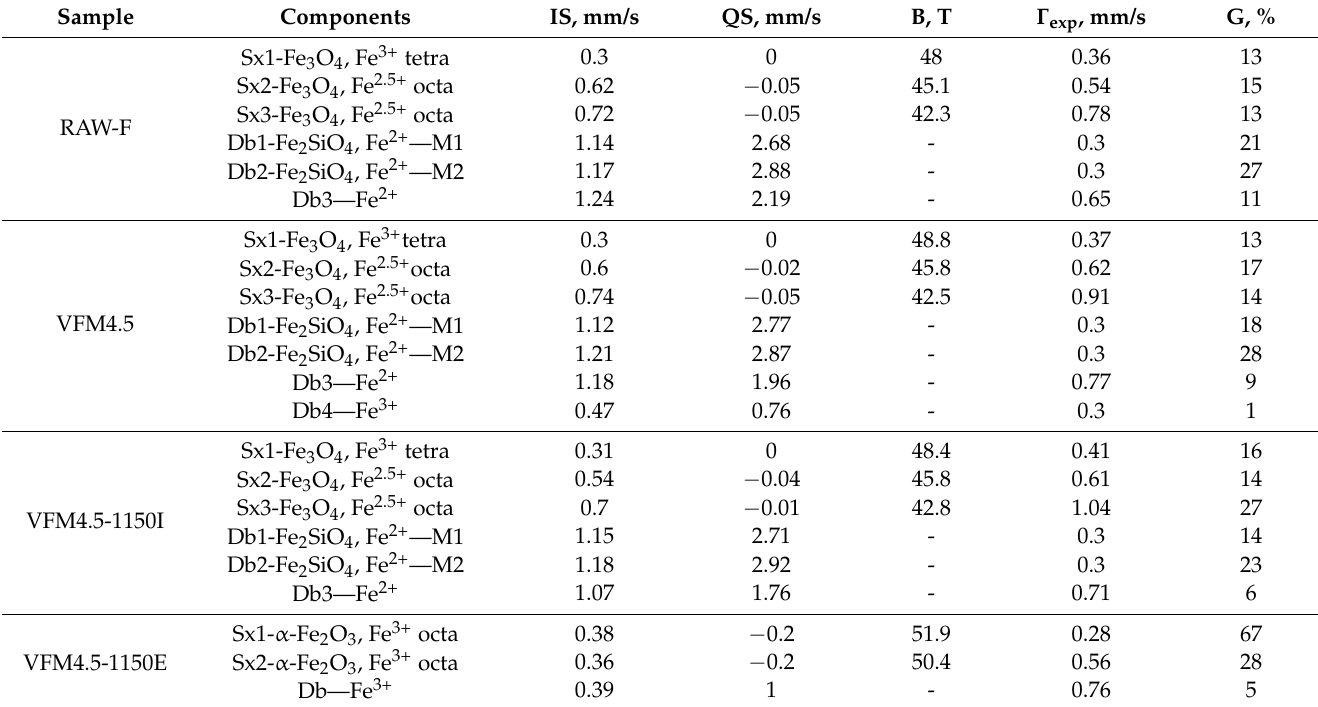
Table 3. Mössbauer parameters of geopolymer precursor (RAW-F), geopolymer series VFM4.5 and sample from interior and exterior part of VFM4.5 exposed to 1150 ◦